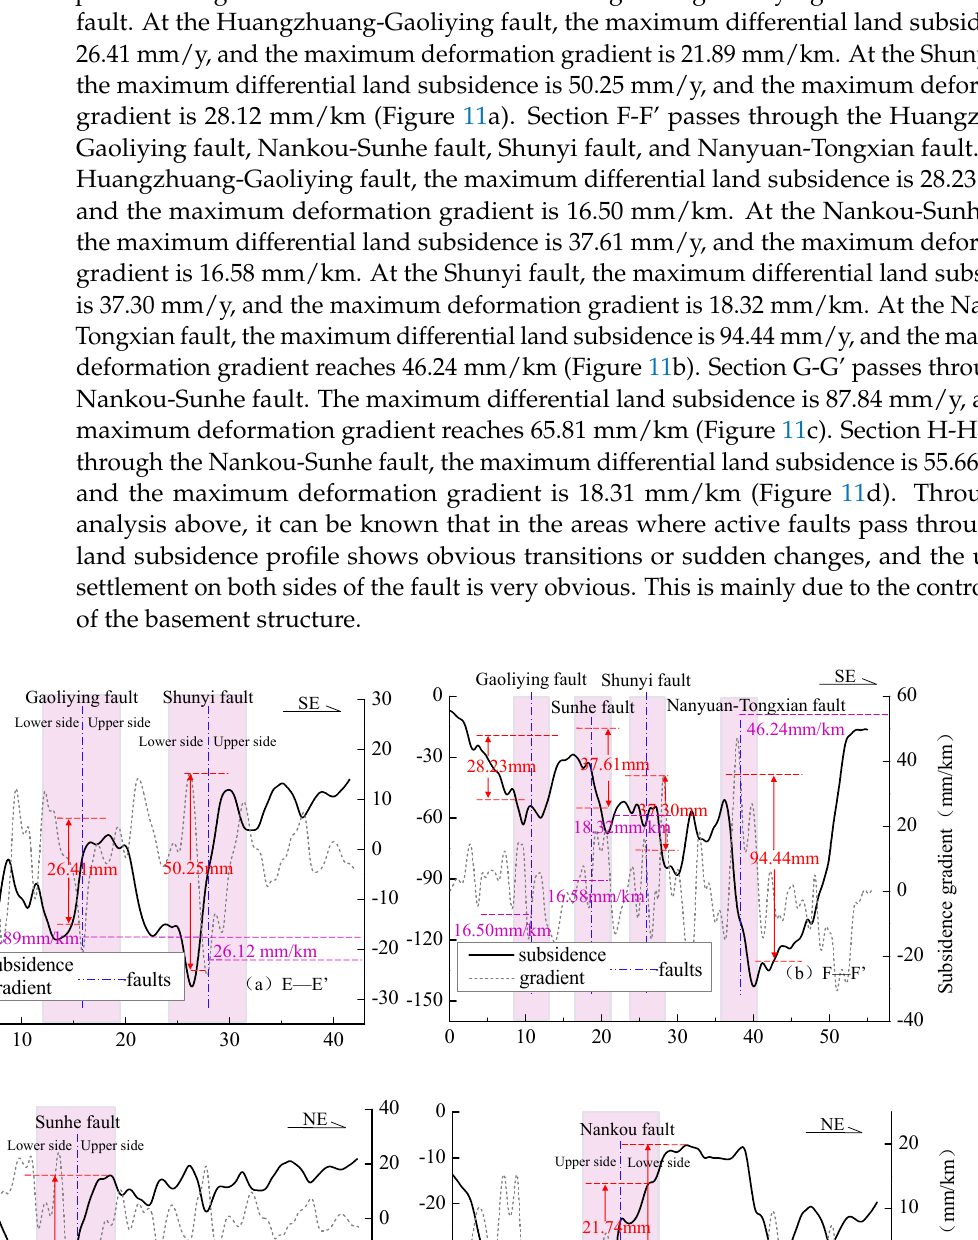
Figure 10. Basement structure and land subsidence distribution, and borehole profiles on both sides of the fault. (a) Main active faults and distribution of land subsidence in 2015. (b) Drilling section on both sides of Huangzhuang-Gaoliying fault. (c) Drilling profile on both sides of the Shunyi fault.